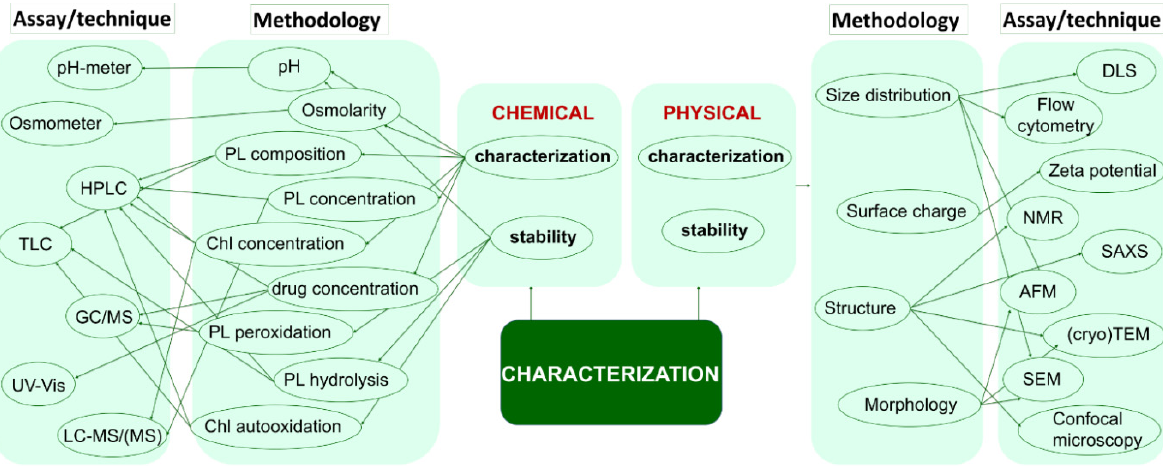
Figure 11. Physico-chemical characterization of liposomes: methodologies and assays/techniques.